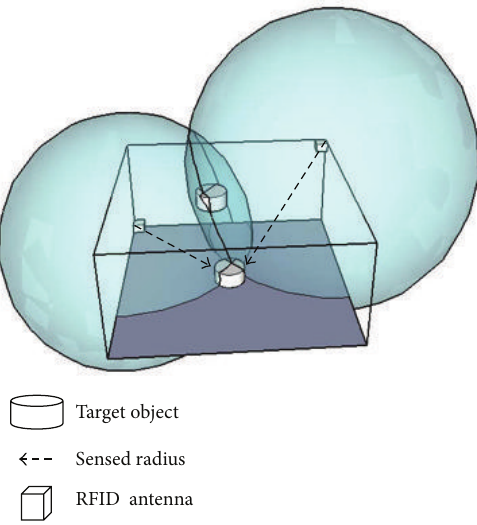
Figure 2: 3D trilateration location